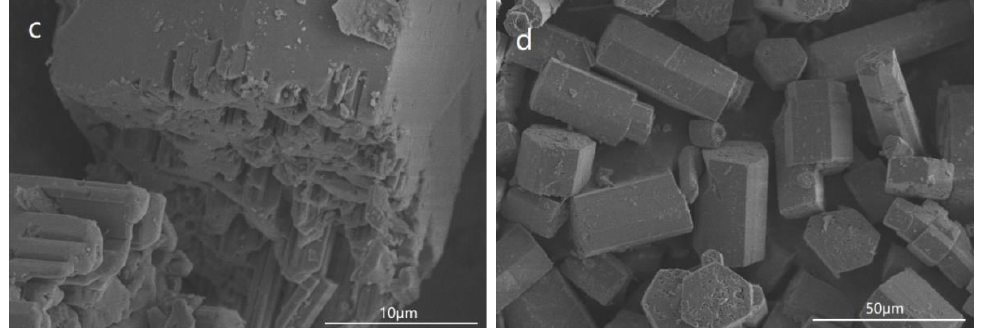
Figure 4. SEM images of samples withdrawn at the reaction stages of ( a ) 140 °C, ( b ) 150 °C ( c ) 150 °C lasting for 10 min and ( d ) 150 °C lasting for 30 min.